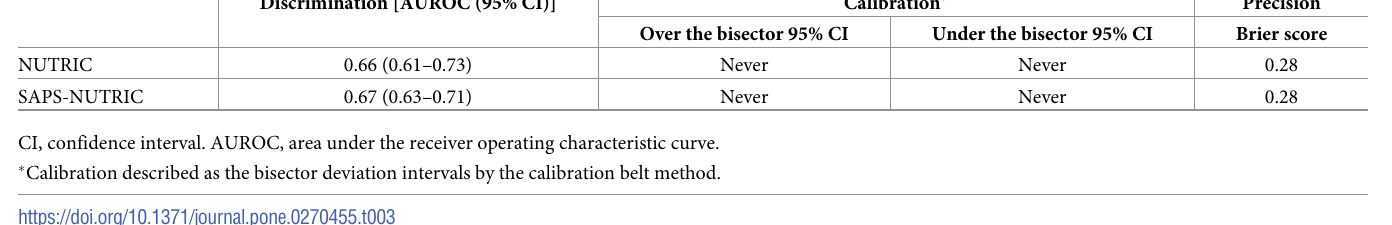
Table 3. Comparison of SAPS 3 performance in all patients and in subgroups of oncological and nononcological patients.